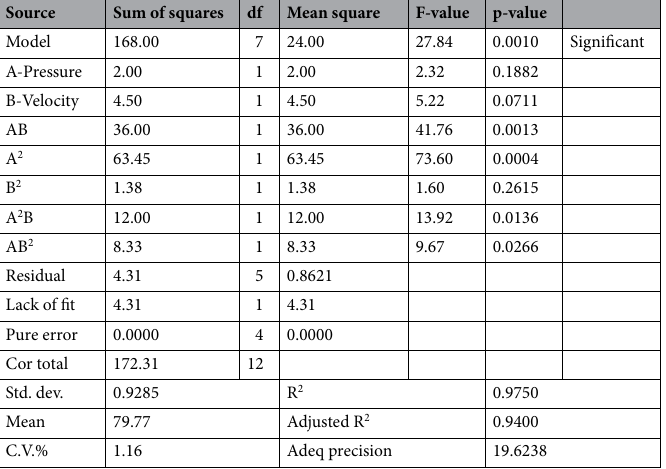
Table 17. ANOVA results for quadratic model (exploitation zone is response) of hot-rolled steel.